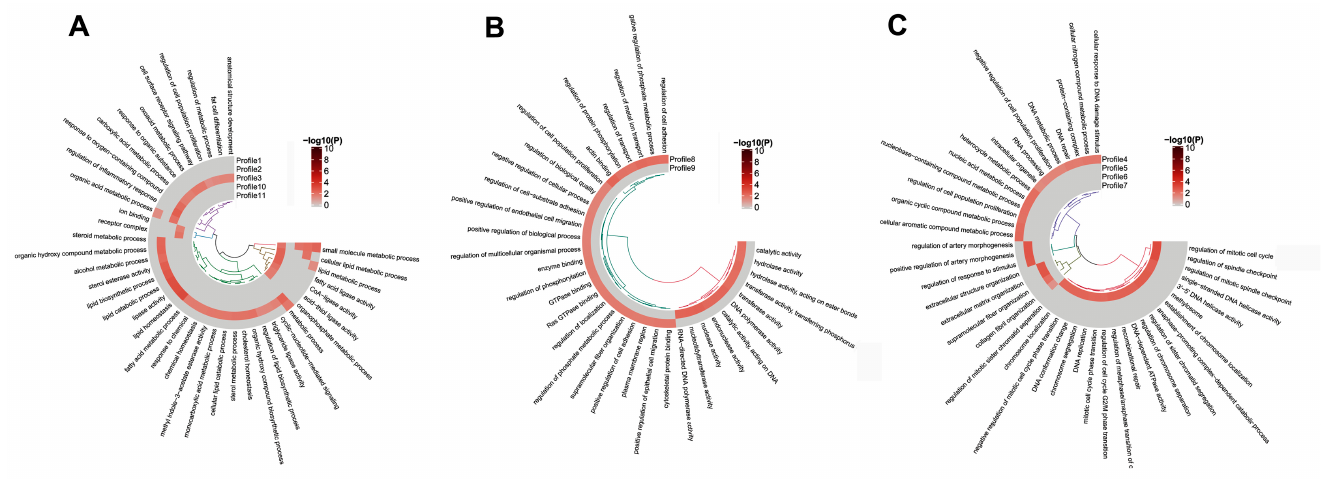
Figure 4. GO analysis of temporal expressed DE mRNAs. ( A ) Significant enriched GO terms for up-regulated genes during the trans-differentiation. ( B ). Significant enriched GO terms for genes showed changes in the differentiated midsection. ( C ). Significant enriched GO terms for down-regulated genes during the trans-differentiation.